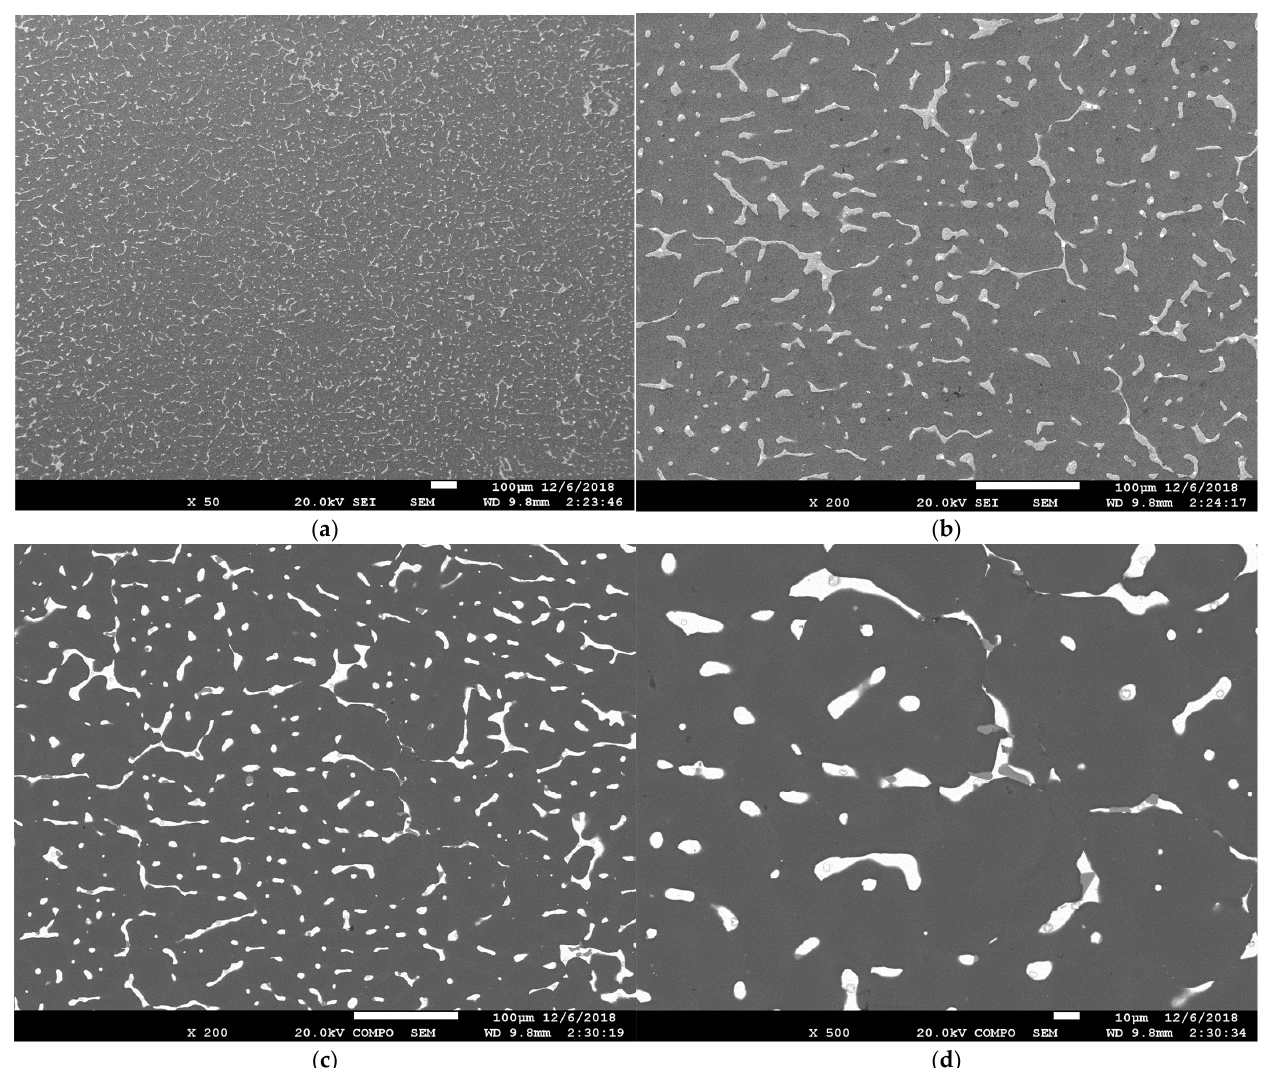
Figure 11. SEM images of a billet produced using semi-solid die casting: ( a , b ) secondary electron imaging, ( c , d ) backscattered electron imaging.